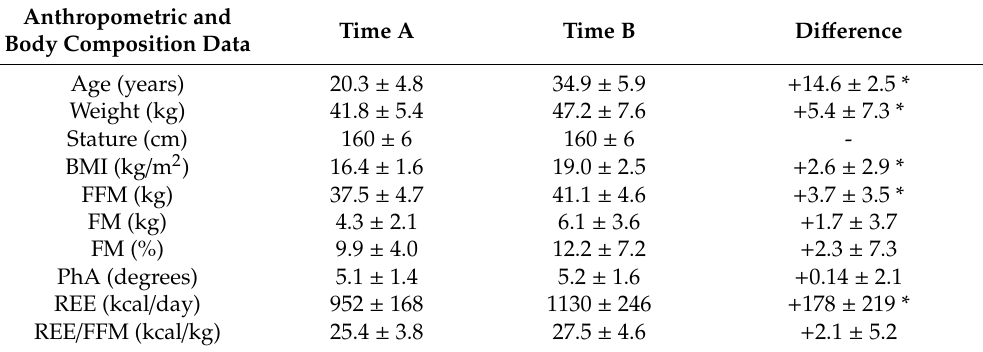
Table 2. Anthropometric and body composition data in the 20 r-AN patients who attended the outpatient unit for the 10-year follow-up re-evaluation—a comparison between current follow-up data (Time B) and data registered at least 10 years earlier (Time